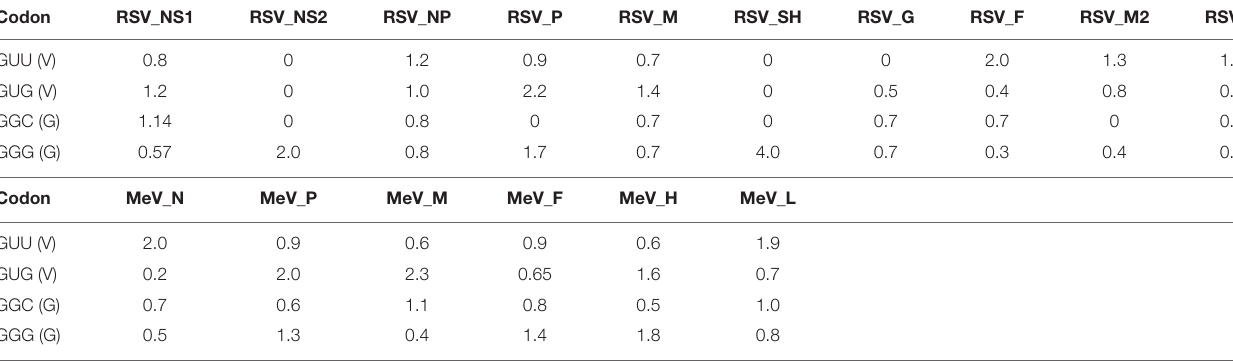
TABLE 3 | RSCU indices for selected codons for MeV and RSV genes.